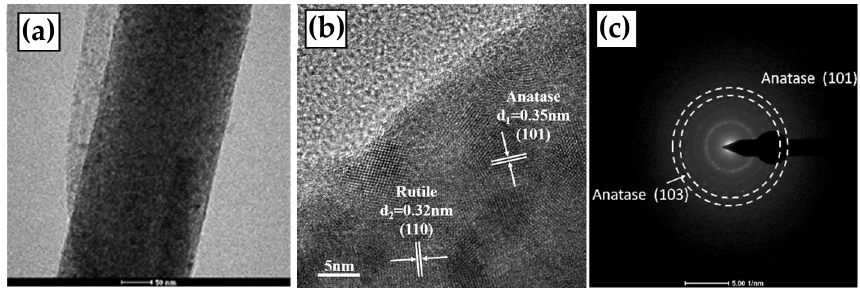
Figure 3. TEM observation of the TiO 2 fiber annealed at 700 °C; ( a ) TEM image of local magnification; ( b ) HRTEM image and lattice annotation of anatase and rutile, and ( c ) calibration of diffraction pattern.